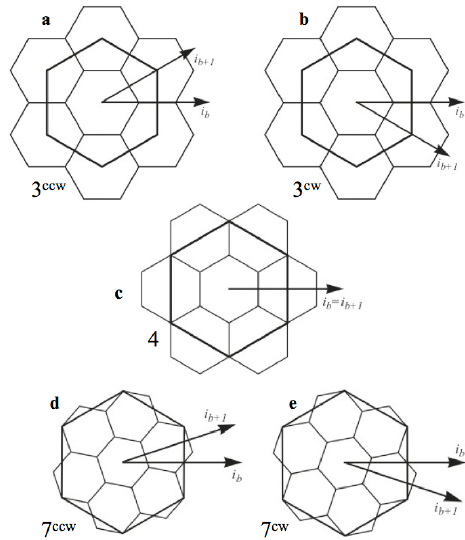
Figure 2. Central place children under all possible central place